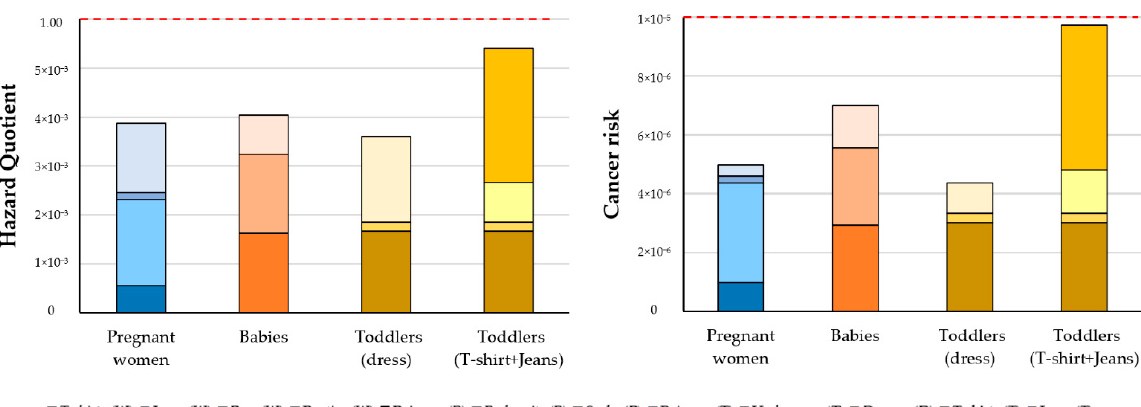
Figure 3. Risk assessment of dermal exposure to formaldehyde in the worst-case scenario, for pregnant women (W), babies (B) aged <12 months, and toddlers (T) aged 12–36 months.